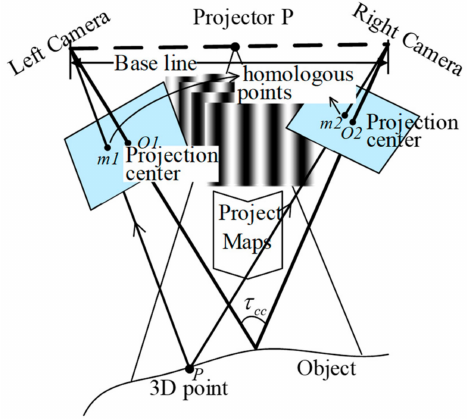
Figure 1. Conventional